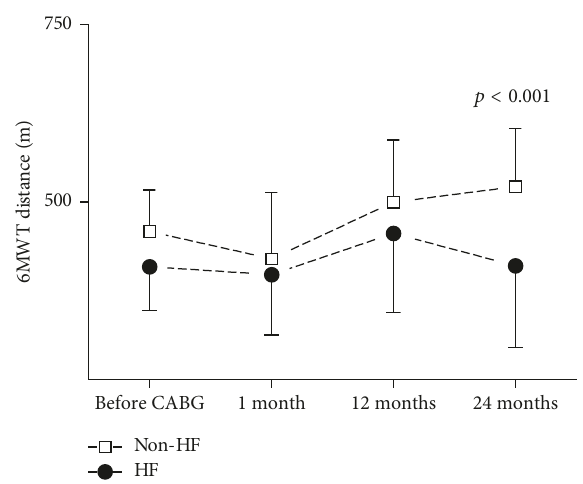
Figure 1: Changes of distance in 6-minute waking test in patients with (HF) and without heart failure (non-HF) during the follow- up. The improvement of the distance 24 months after CABG was observed only in non-HF group, and the distance was significantly longer as compared to the HF patients.